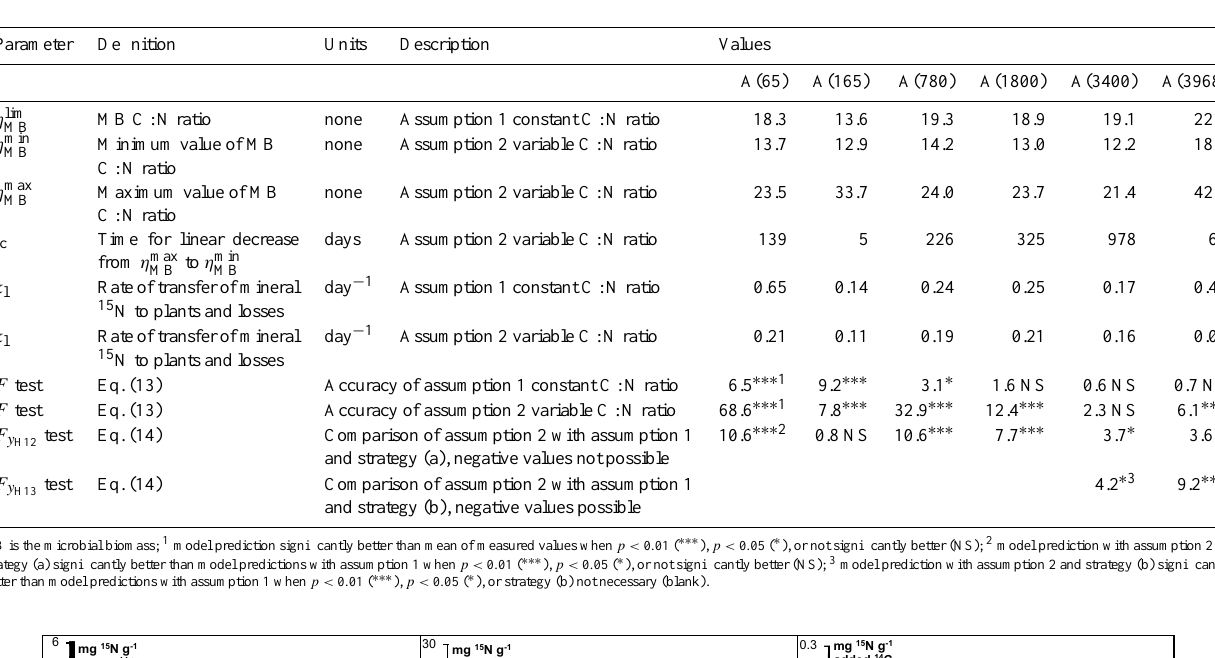
Table 4. Values and significance of additional parameters for MOMOS-N (this study).